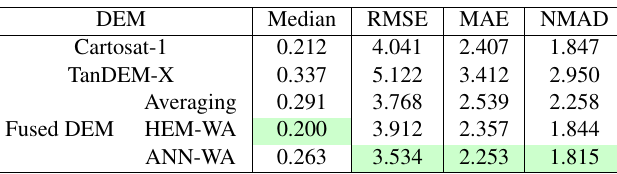
Table 2. Accuracies of TanDEM-X and Cartosat-1 DEM fusion based on HEM-weighted averaging (accuracies in meter).